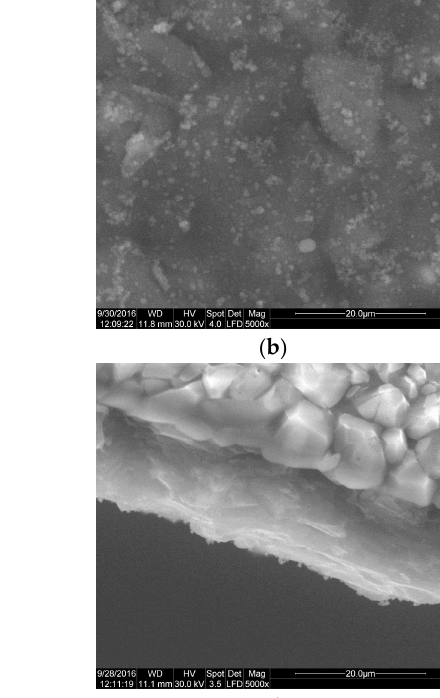
Figure 3. Frontal ( a , b ) and transversal ( c , d ) SEM images of the unmodified ( a , c ) and modified ( b , d ) SPCE.